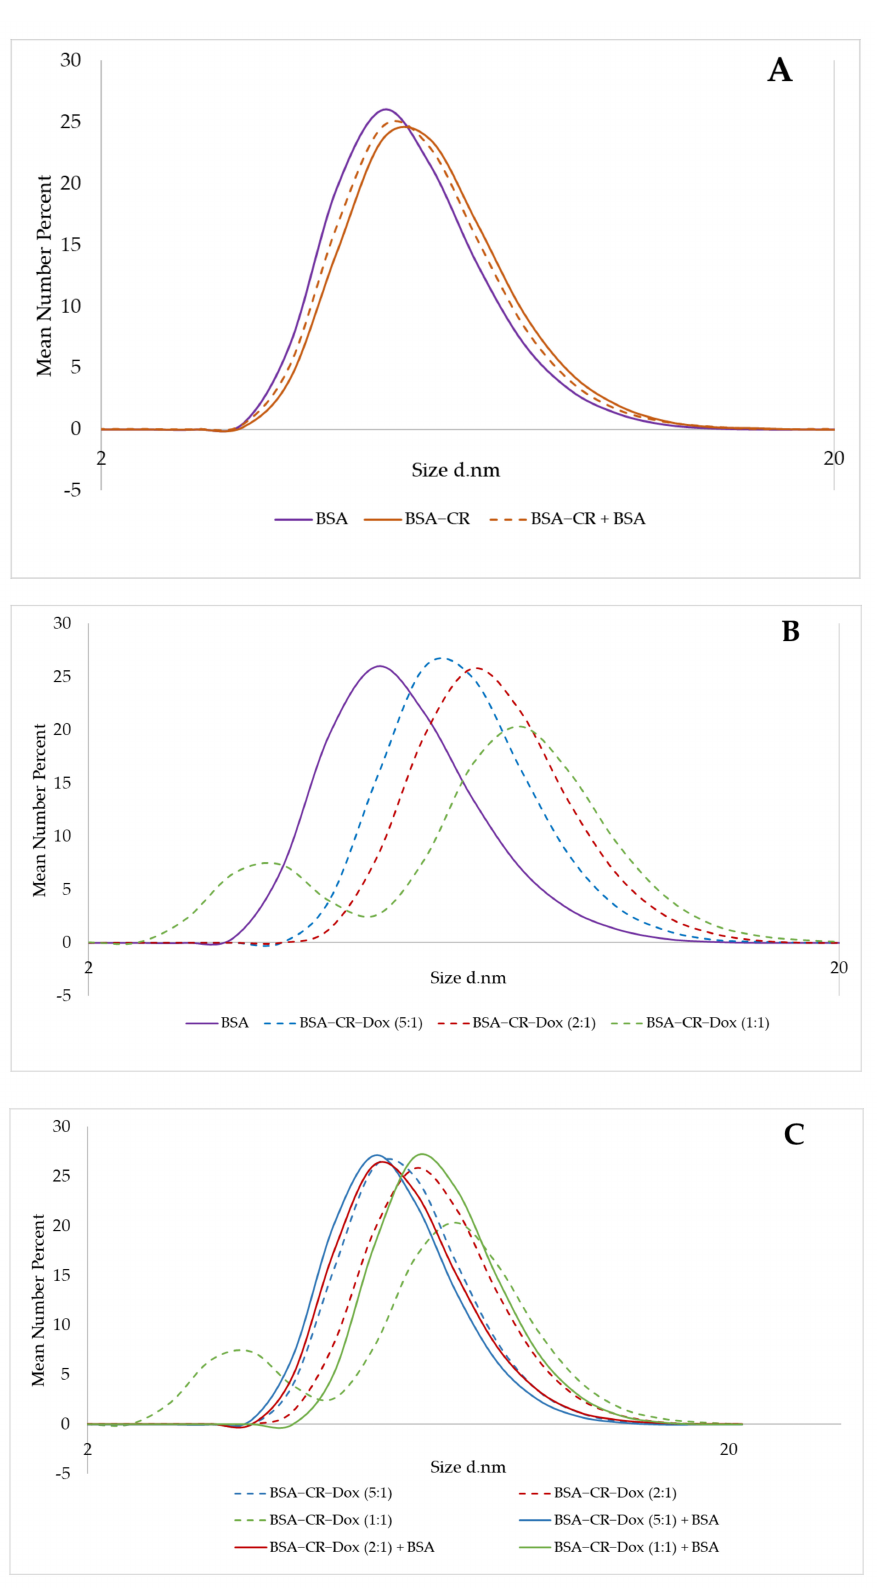
Figure 5. DLS analysis. Hydrodynamic diameter distribution measurements. Mean number (%). ( A ) small changes in the diameter of BSA after binding of CR (from 4.85 nm to 5.6 nm) and no significant changes after addition of an extra portion of BSA (5.6 nm before and after addition of extra BSA); ( B ) increase in the size of BSA–CR–Dox complexes after addition of an increasing amount